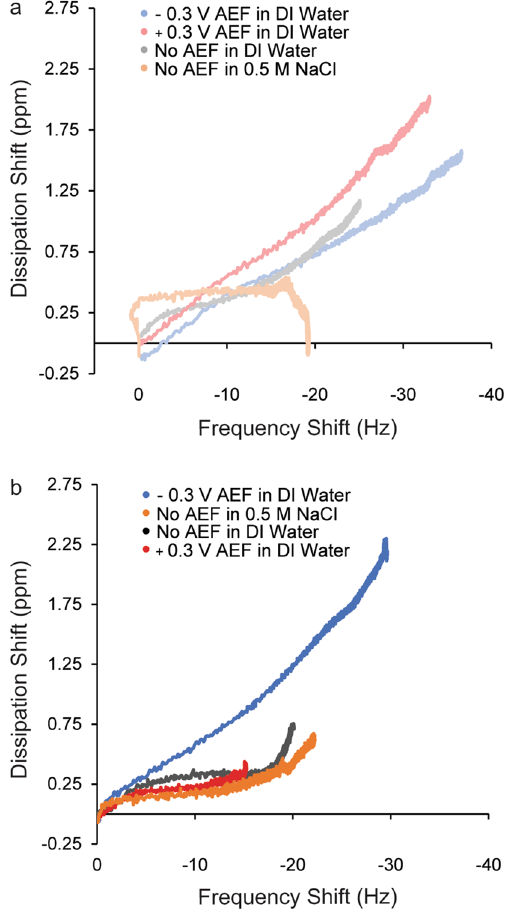
Figure 4. DF plots reveal that peptide charge, salt and AEF influence grafting mechanism. Data are shown from the grafting of ( a ) uncharged ELP (light color) and ( b ) (−)charged ELP (bold color) at different grafting conditions: − 0.3 V AEF in DI water (light blue and blue, respectively), + 0.3 V AEF in DI water (pink and red, respectively), no AEF in DI water (gray and black respectively), and no AEF in 0.5 M NaCl (light orange and orange respectively). All voltages are vs. a Ag/AgCl